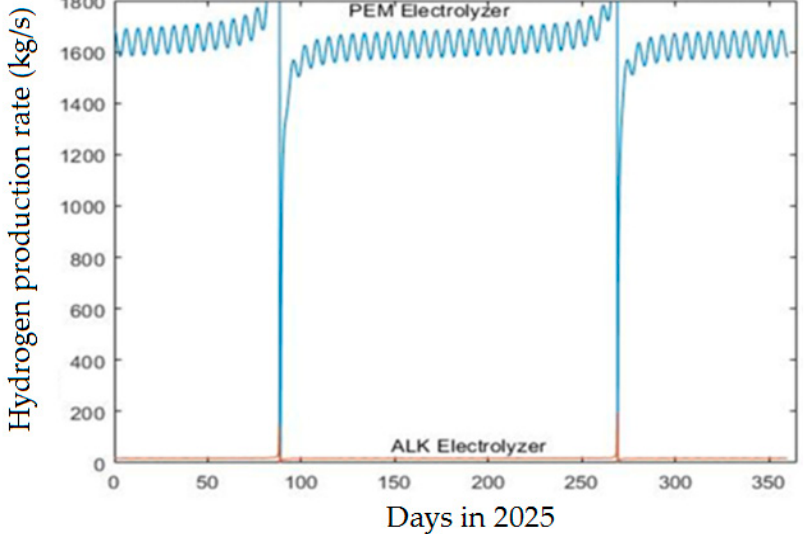
Figure 11. ALK versus PEM production rate using 1000 m 2 capacity of solar PV.